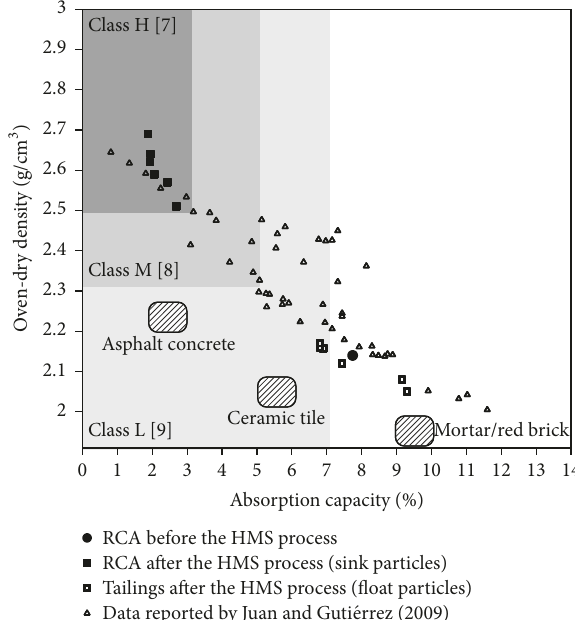
Figure 9: The relationship between oven-dry density and absorp- tion capacity of sink and float in the heavy media separation process and impurities in the mixed CDW RCAs in